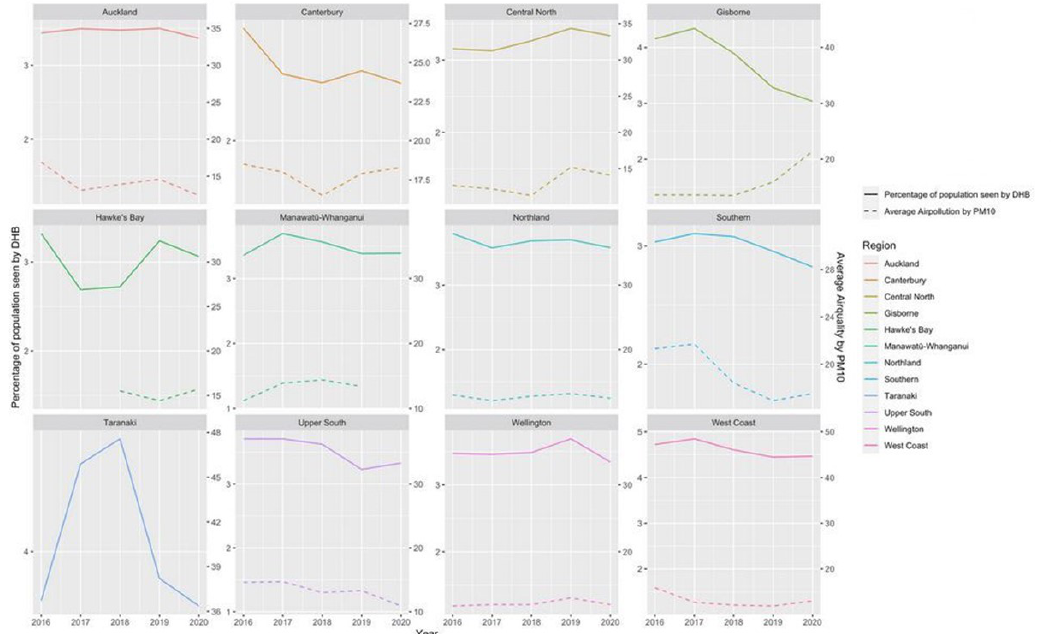
Figure 5. Average air pollution levels compared to the rate of the population seen by